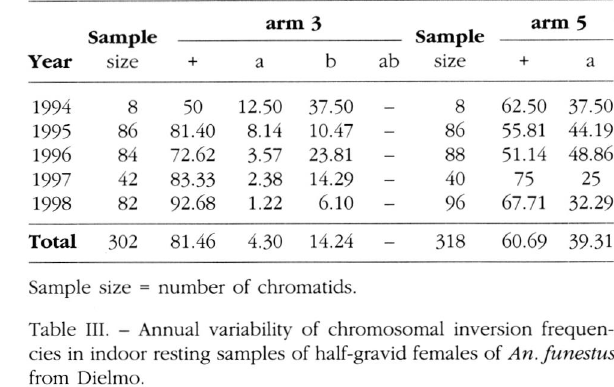
Table III. - Annual variability of chromosomal inversion frequen cies in indoor resting samples of half-gravid females of An. funestus from Dielmo.